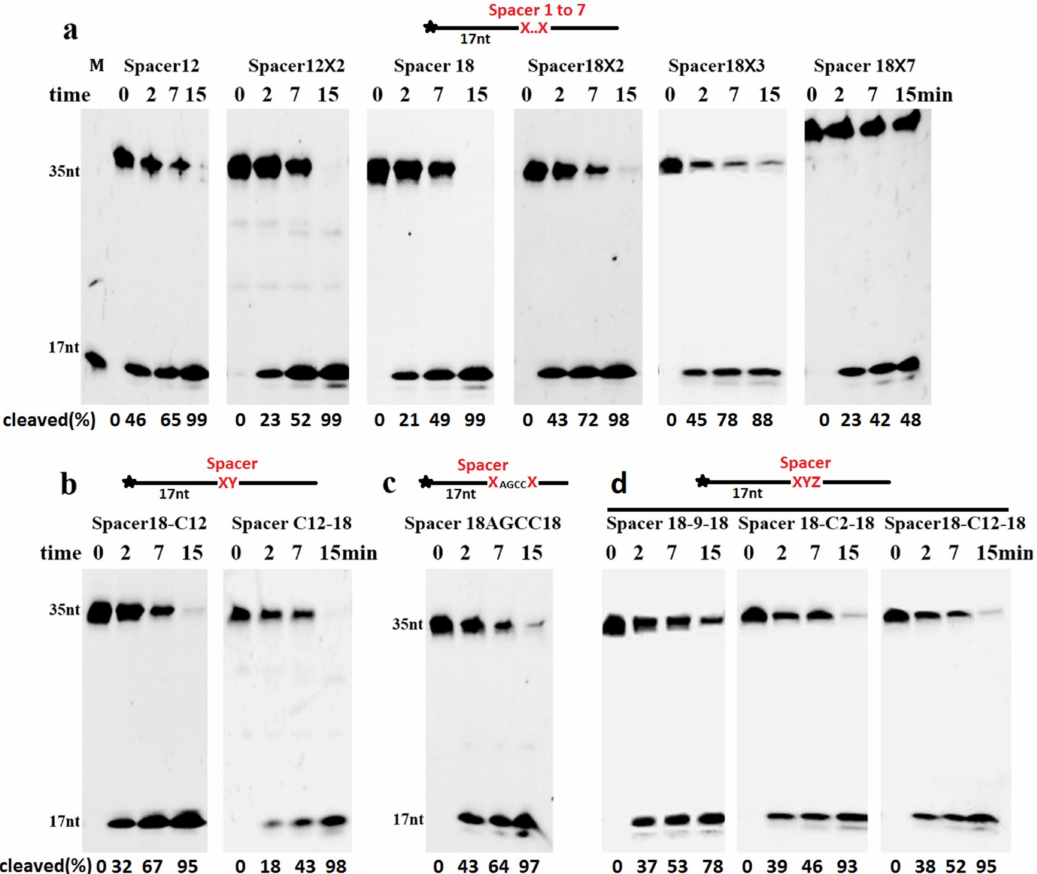
Figure 4. Cleavage of ssDNAs containing clustered AP site analogues. The ssDNAs (100 nM) containing ( a ) consecutive Spacer C12 or 18, ( b ) tandem Spacers C12 and 18, or ( c ) tandem Spacer 18 separated by four normal bases or ( d ) a different middle AP site analogue were incubated with TeuendoIV (5 nM) at 55 ◦ C for the indicated time. The combinations of AP site analogues are listed on the top of each panel. Uppercase letter M denotes oligonucleotides marker. The cleavage percentages of substrates are listed at the bottom of each panel. The symbol of black asterisk and the red letters X, Y and Z denote the fluorescein (6-FAM) group at the 5 (cid:48) -end and the AP-sites,